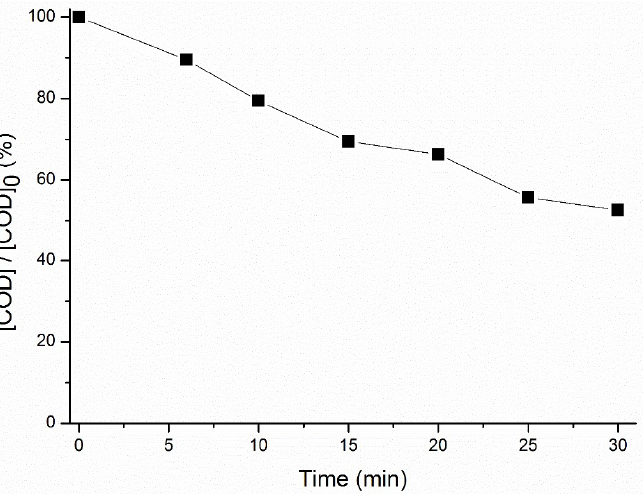
Figure 3. COD removal for the MW (pH 7) spiked with five PPCPs (MP, PP, PCT, SMX and CBZ), at 1 mg L −1 each, during ozonation.